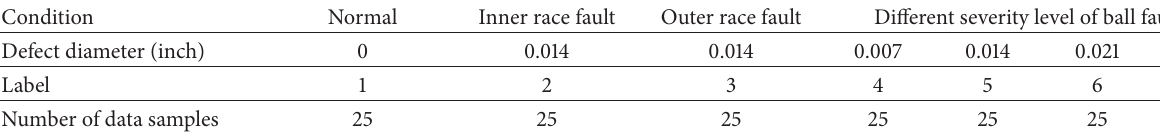
Table 2: Statistics of each fault condition of bearing.